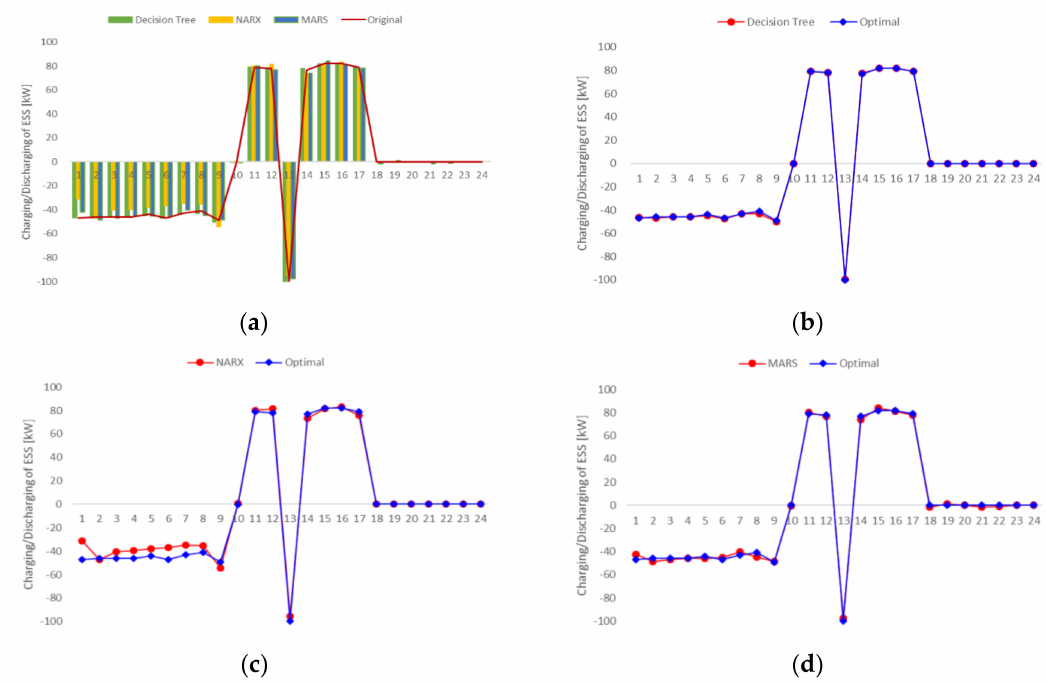
Figure 11. ( a ) Optimal schedule of ESS for minimization of operation cost at spring, ( b ) real and simulation results with DT, ( c ) real and simulation results with NARX, ( d ) real and simulation results with MARS.